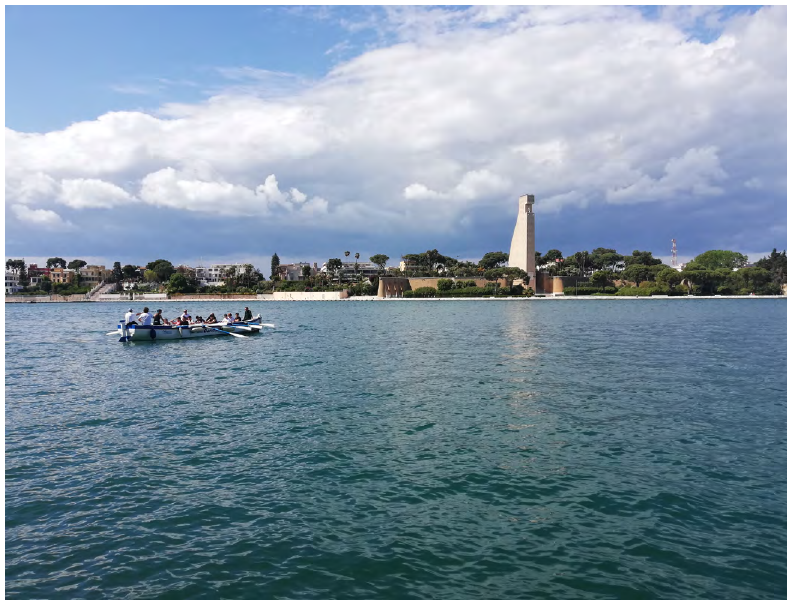
FIG. 2 Traditional rowing in the inner harbour of Brindisi. Photo by Silvia